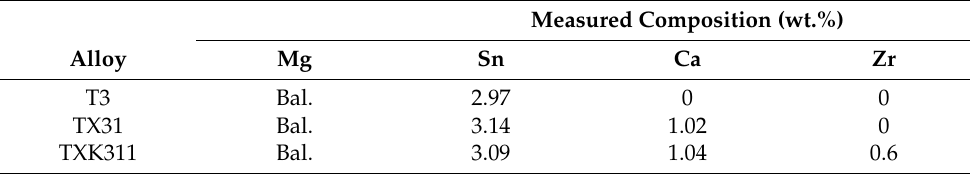
Figure 2. Metallographic sampling location of as-extruded alloy. Table 1. Actual chemical composition of as-extruded alloy. Measured Composition (wt.%)